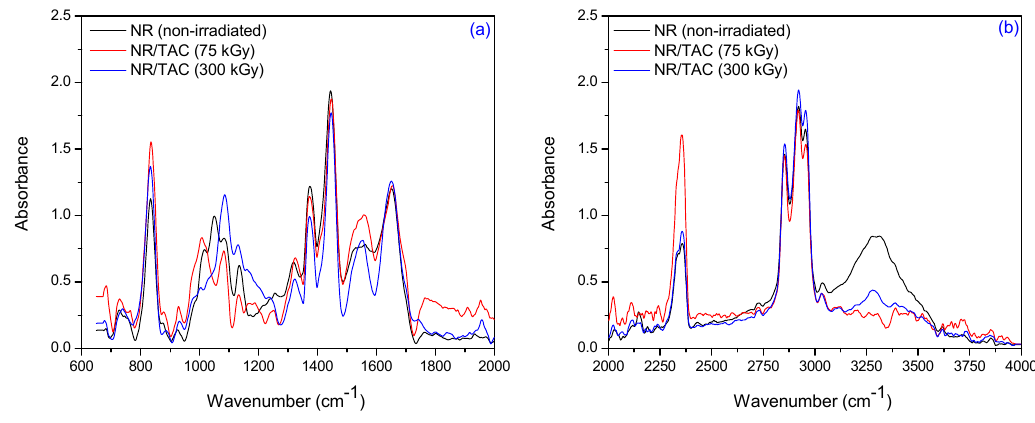
Figure 12. FTIR spectra in the range of ( a ) 2000 cm − 1 –600 cm − 1 and ( b ) 4000 cm − 1 –2000 cm − 1 for NR/TAC samples, irradiated at 75 kGy and 300 kGy.